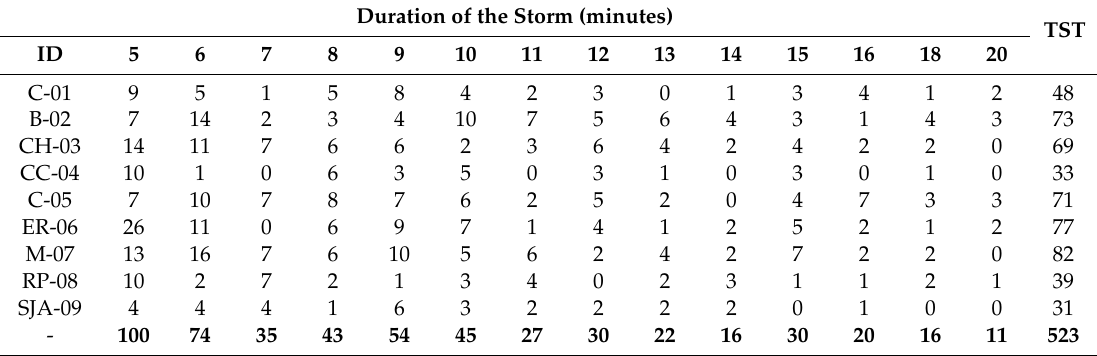
Table 2. Number of storms (ST i ) for some stations of Queretaro rainfall warning system (RedCIAQ).